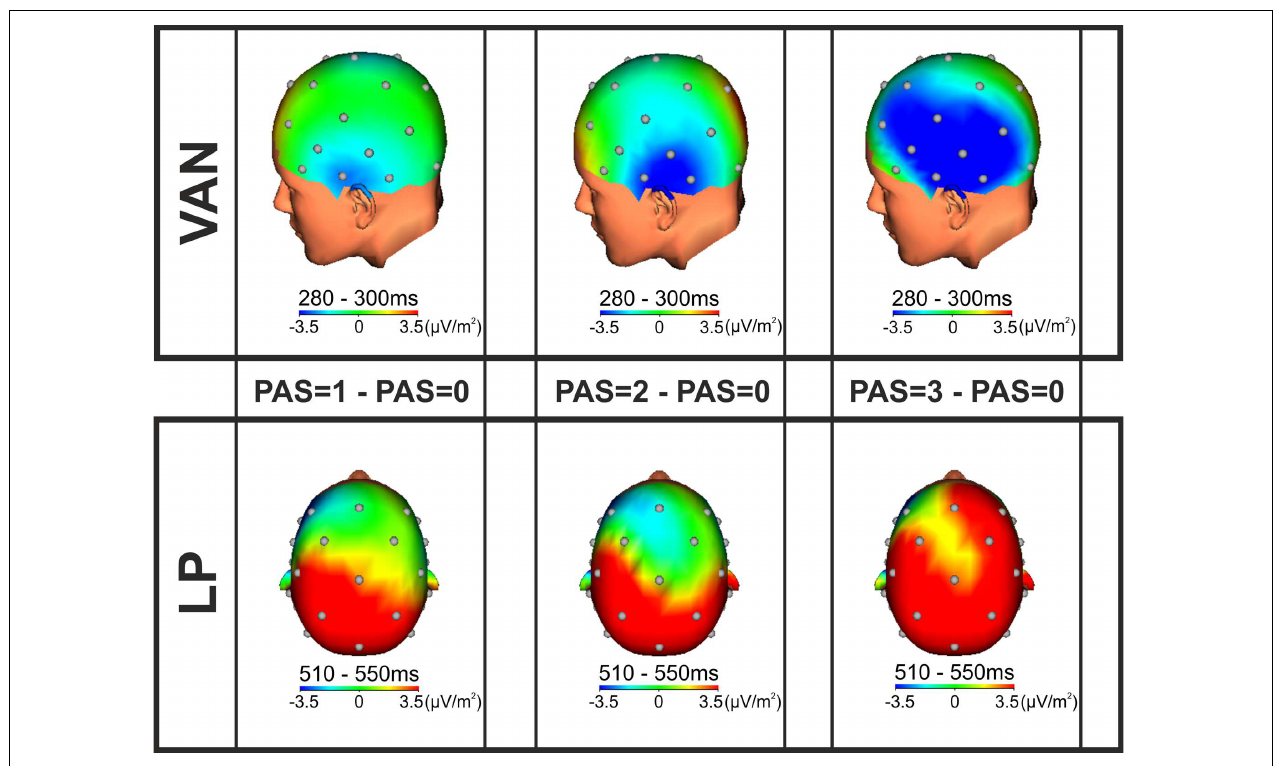
FIGURE 3 | SCD topographic maps. SCD foci for the VAN ( upper ; time window from 280 to 300 ms) and LP ( lower ; time window from 510 to 550 ms) components performed on the grand average of the differences between each conscious condition (PAS = 1, 2, and 3) and the unconscious condition (PAS = 0).